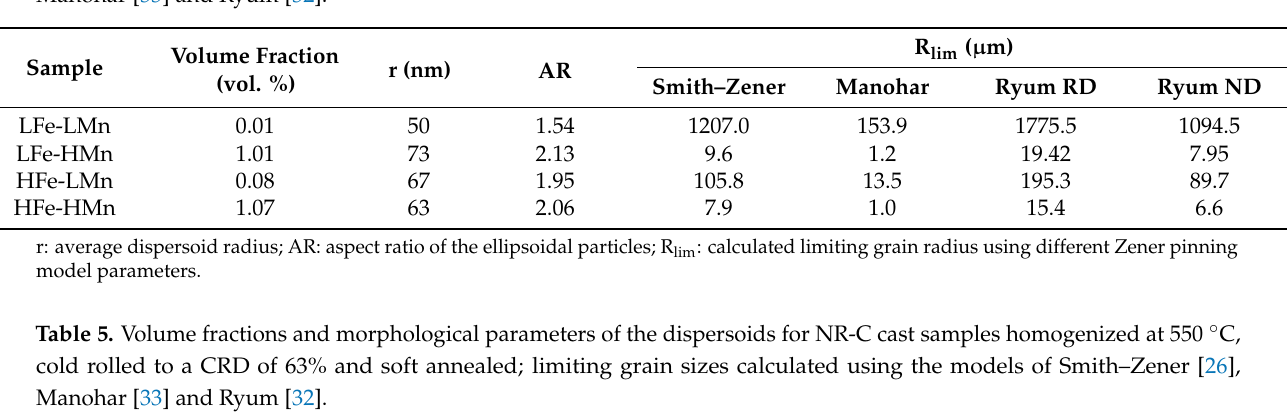
Table 4. Volume fractions and morphological parameters of the dispersoids for NR-C cast samples homogenized at 500 ◦ C, cold rolled to a CRD of 63% and soft annealed; limiting grain sizes calculated using the models of Smith–Zener [26], Manohar [33] and Ryum [32].